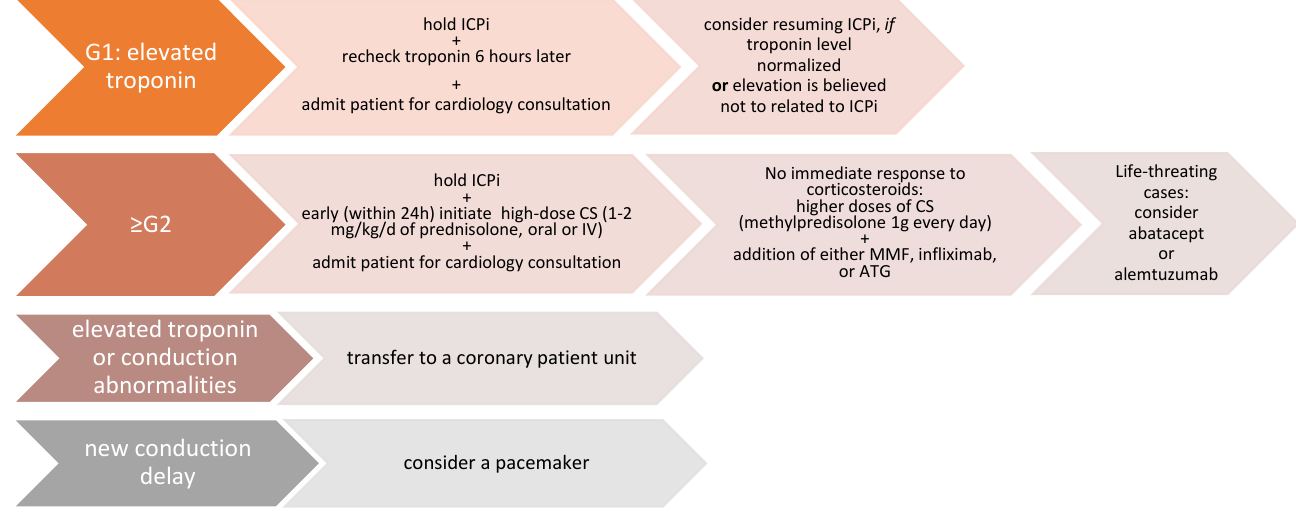
Figure 4. Management of cardiovascular toxicities, including myocarditis, pericarditis, arrhythmias, impaired ventricular function with heart failure, and vasculitis. Based on [78]; G1—grade 1, G2— grade 2 (see Table 3), ICIs—immune checkpoints inhibitor, CS—corticosteroid, MMF—mycophenolate mofetil, ATG—anti-thymocyte globulin. Table 3. Grading of cardiovascular toxicities, including myocarditis, pericarditis, arrhythmias, impaired ventricular function with heart failure, and vasculitis. Based on [78]. Abnormal cardiac biomarker testing without symptoms and with no G1 ECG abnormalities